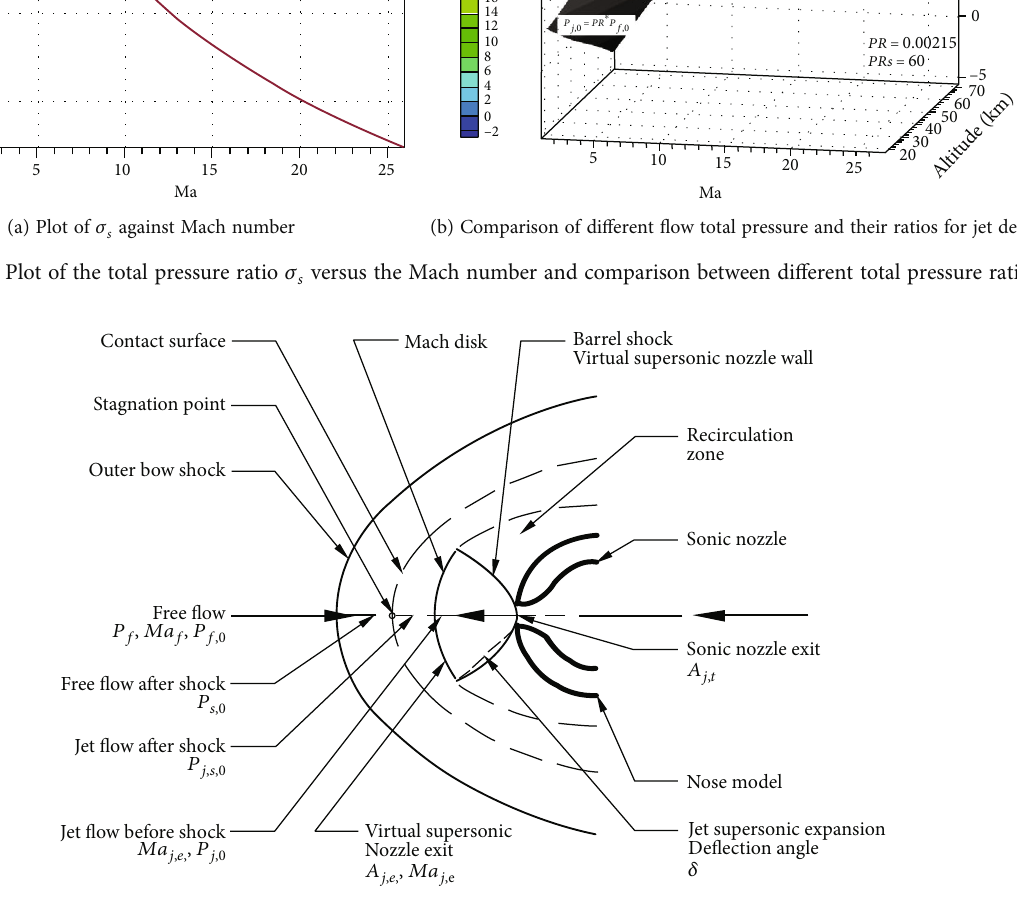
Figure 2: Concept of the virtual supersonic